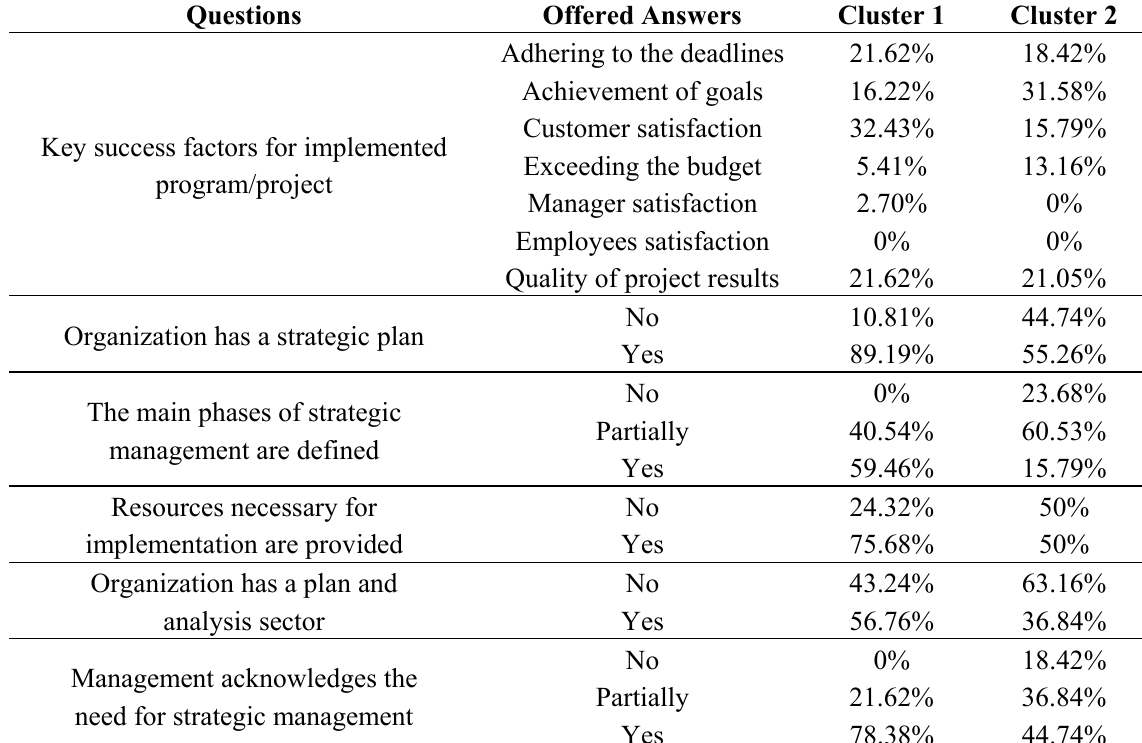
Figure 2. Distribution of cluster centers for each of the questions in the questionnaire. Figure 2 presents cluster centers for each question relating to project maturity. Namely, cluster center curves represent values closest to organizations belonging to a certain cluster. Table 4. Comparison of clusters in terms of organizational strategic